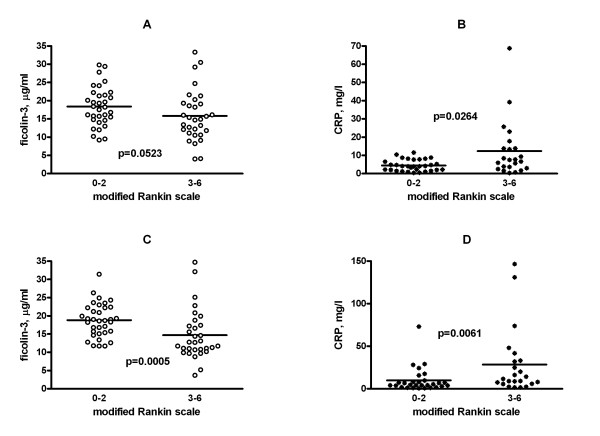
Relationship of serum ficolin-3 and CRP levels with outcome. Differences in ficolin 3 (left panels, A, C) and CRP (right panels, B, D) levels measured in admission samples (upper panels, A, B) and in follow-up samples (lower panel, C, D) comparing patients with a favorable (modified Rankin scale: 1 or 2) and an unfavorable (modified Rankin scale 3 to 6) outcome. In the case of the CRP calculations, nine patients with infectious complications were excluded from the analysis. The significance of the Mann-Whitney test is indicated.